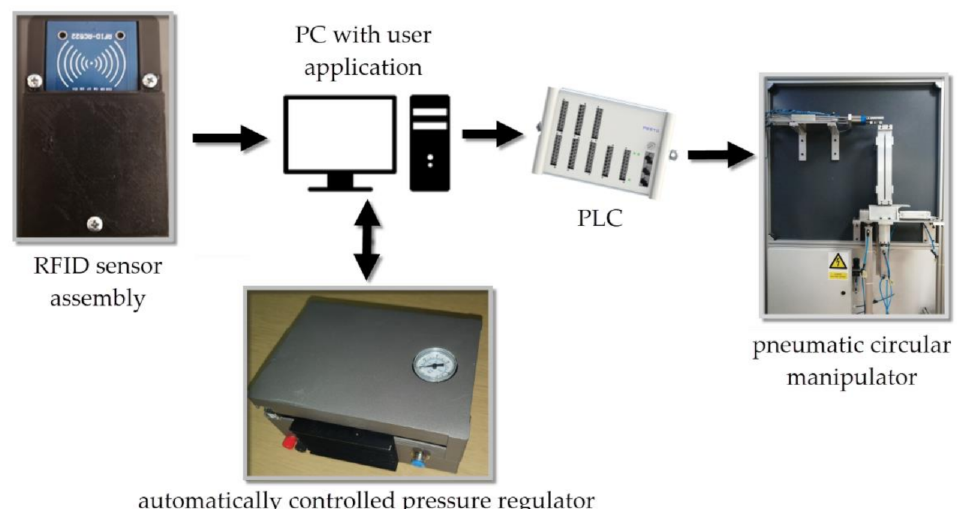
Figure 9. Ways of